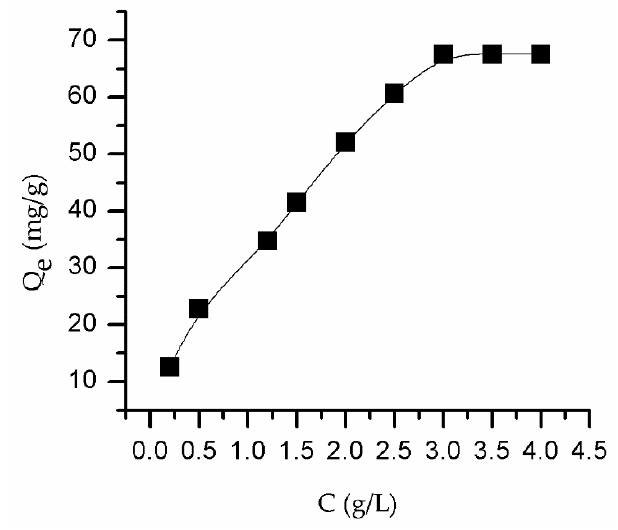
Figure 12. The adsorption thermodynamics of the SSO-MIPs.